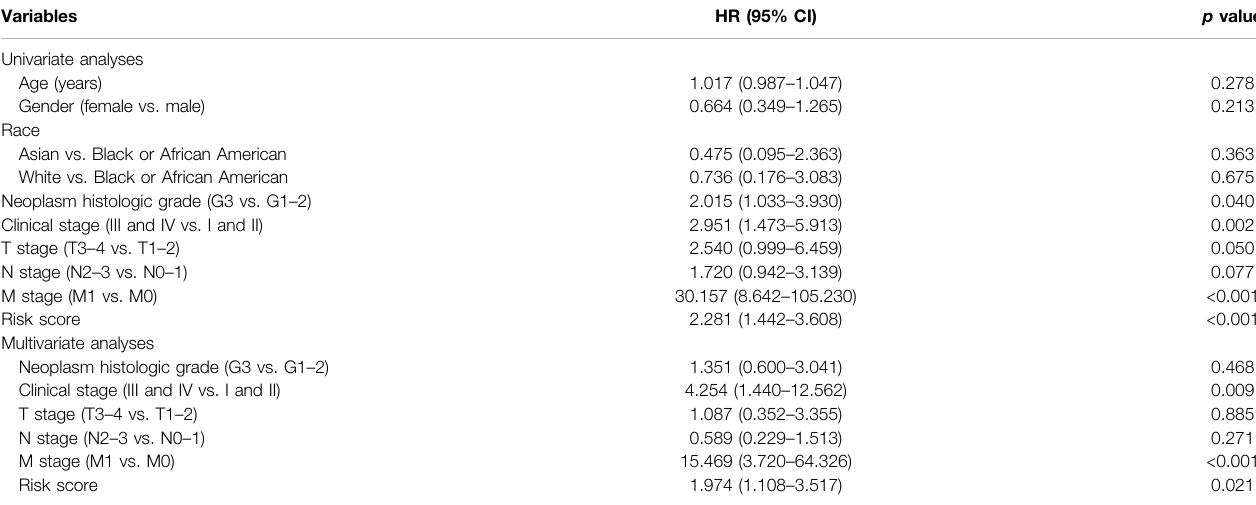
TABLE 3 | Univariate and multivariate analyses of risk factors with and OS in the validation cohort. Variables p value Univariate analyses Age